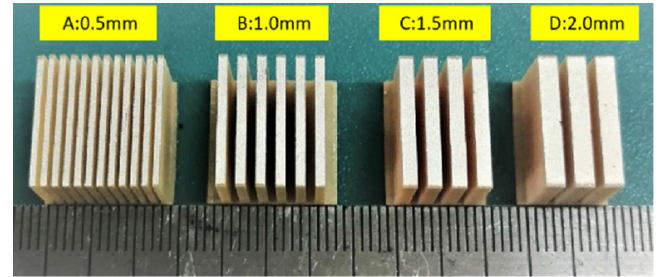
Figure 1. Piezoelectric ceramic sheet sizes.